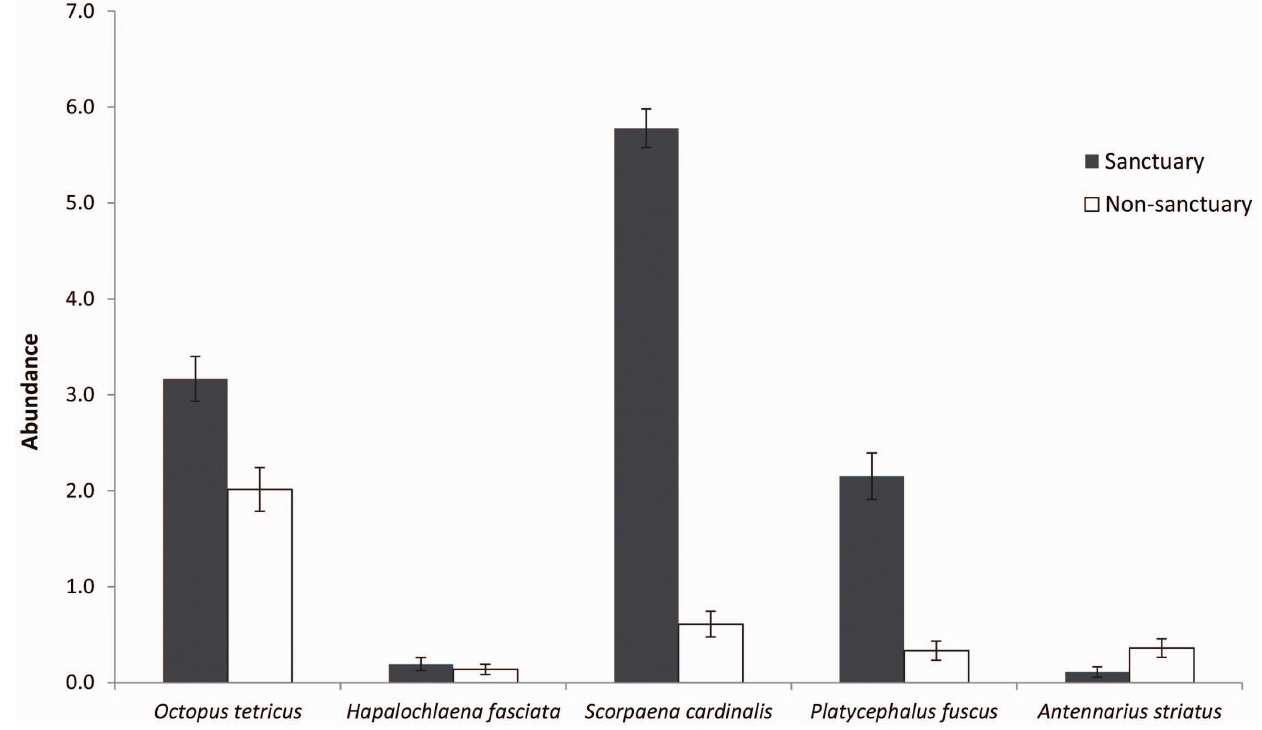
Figure 5. Monthly mean abundance ( ± S.E.) in 2007–2009 of seahorse predators at two sites within the Fly Point Sanctuary Zone and at two sites outside the Sanctuary Zone.